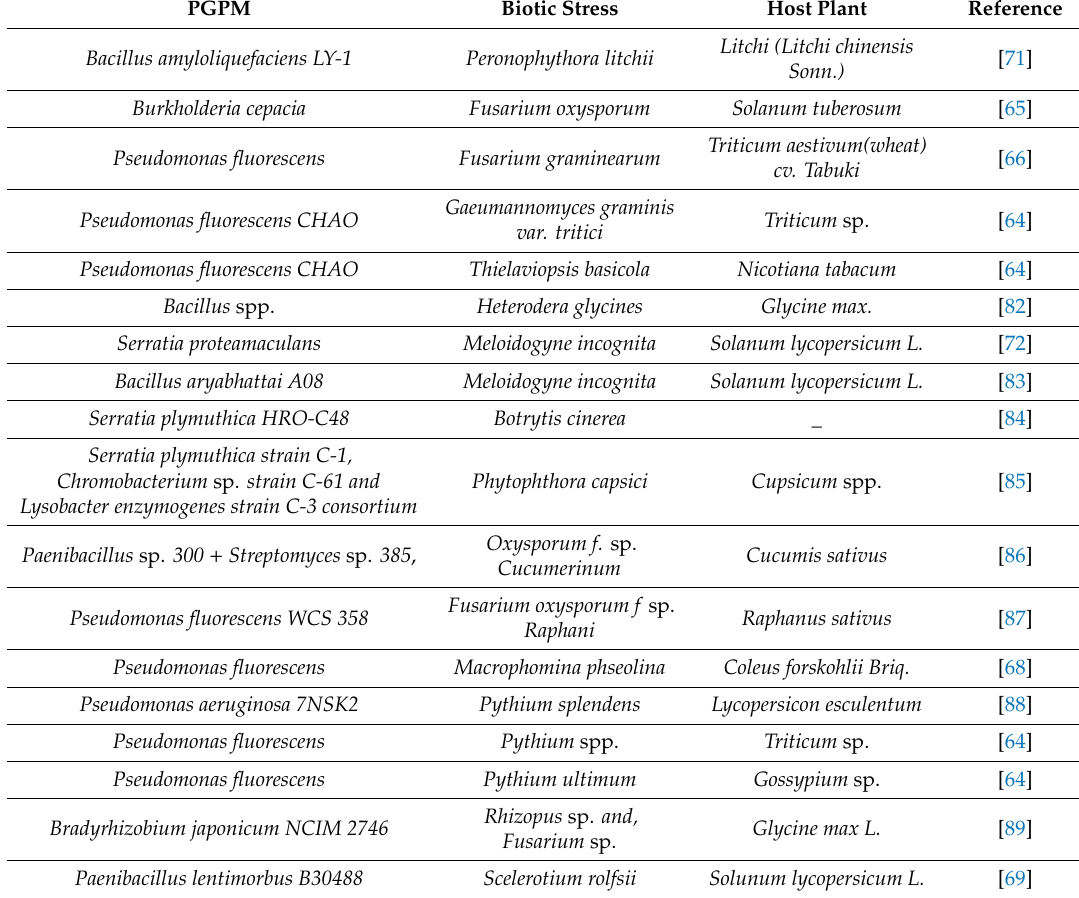
Table 1. Biocontrol species against biotic stressors of di ff erent crop species. PGPM Biotic